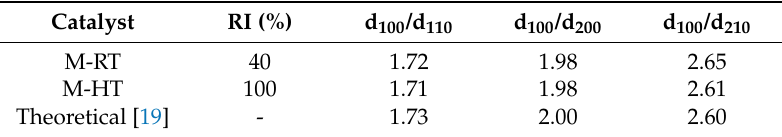
Figure 5. XRD patterns of the as-synthesized and calcined silicas. Table 1. Relative intensities (RI) of the peaks corresponding to the (100) planes of the as-synthesized silicas, and interplanar distance